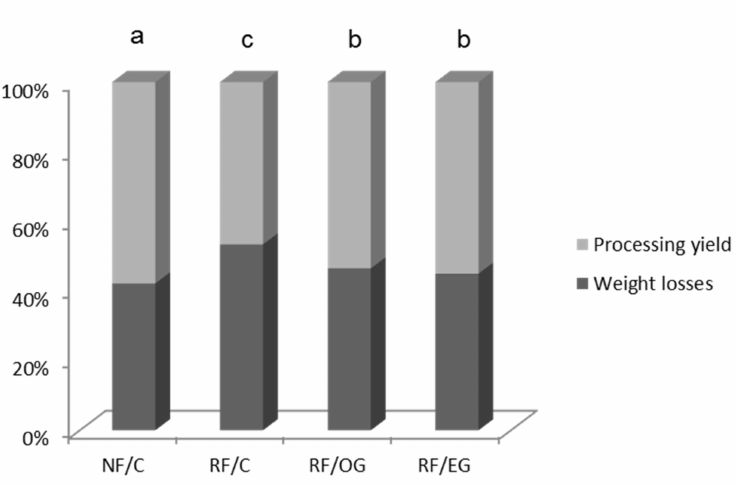
Figure 1. Weight losses and the processing yield of the fuets as a consequence of the ripening process. Normal fat (NF / C) and reduced-fat (RF / C) dry fermented sausages (fuet) formulated with all-animal fat. Reduced-fat fuets reformulated by partially replacing (80%) pork backfat with oleogel (RF / OG) or emulsion gel (RF / EG). Di ff erent letters indicate significant di ff erences by formulation in weight losses and processing yield ( p <